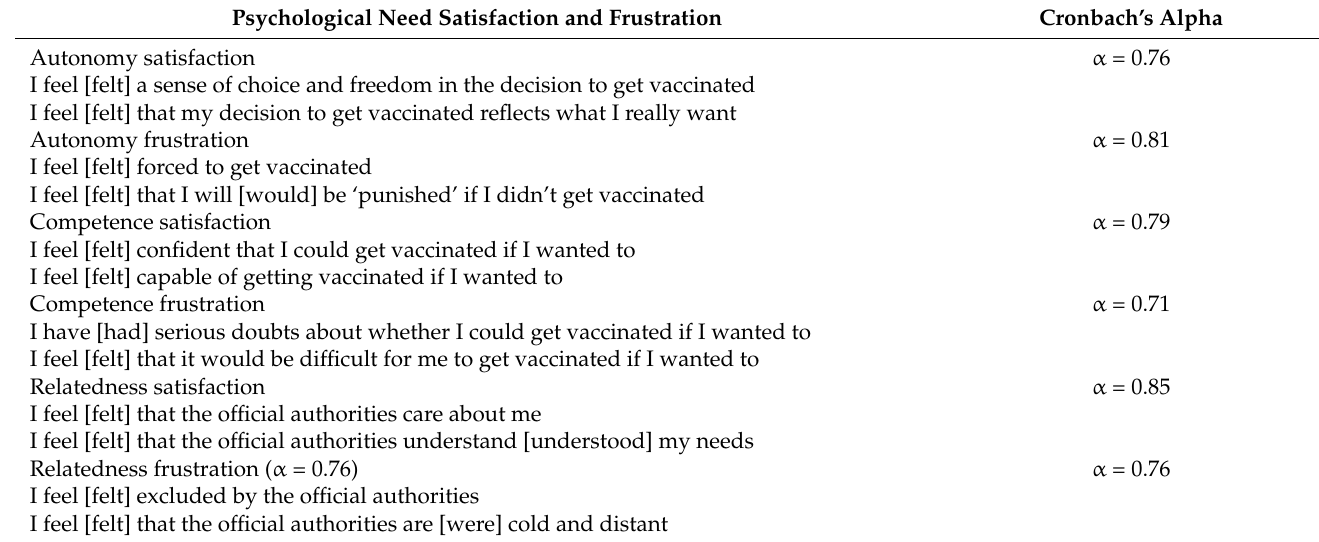
Table 1. The items for the 6 basic psychological needs, including their Cronbach’s alpha coefficient of reliability. Psychological Need Satisfaction and